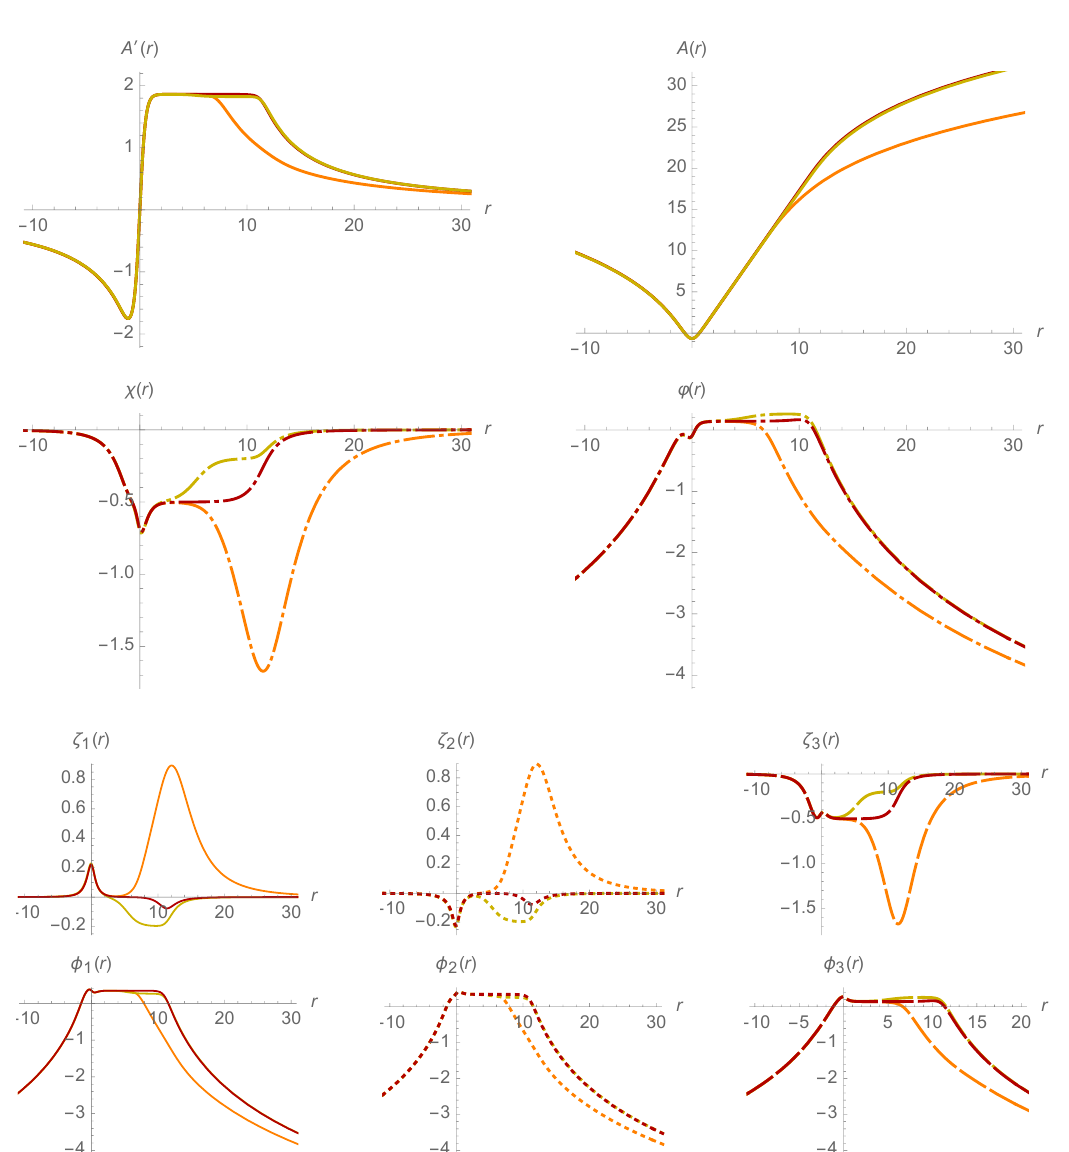
Figure 23. SYM/ U(3) N = 1 Janus solutions with SO(3)